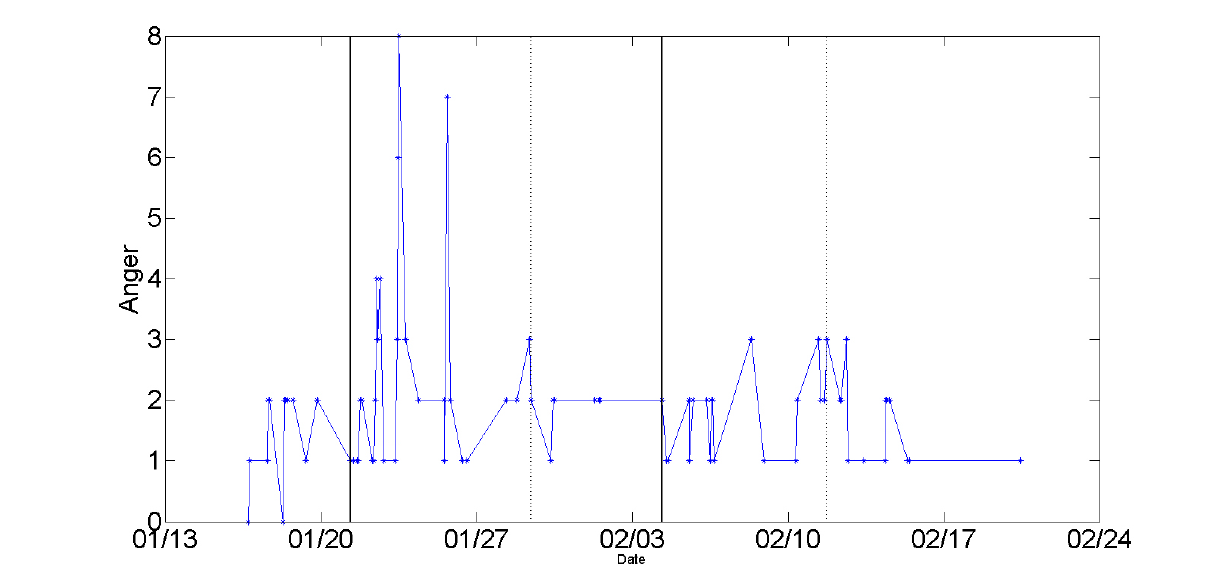
Figure 9. Snapshots of two comparably stressful episodes (1/21 to 1/29 and 2/4 to 2/11) identified by Forest during interviews. The solid and dotted vertical lines mark the beginning and end of the episodes respectively. In the second episode, he applied stress management and conflict resolution techniques and reported less anger.